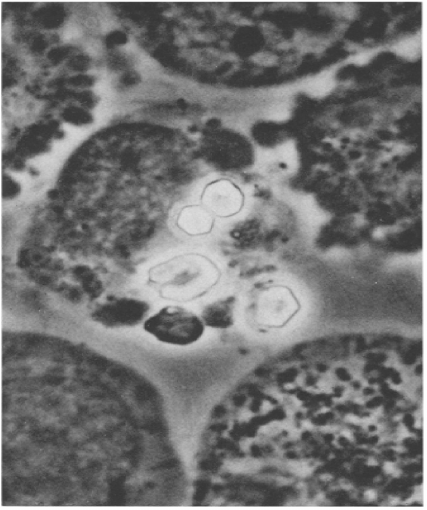
Figure 1. Cystine crystals seen in an unstained bone marrow aspirate obtained from a child at 10 weeks of age. (Phase Optics. × 1280)